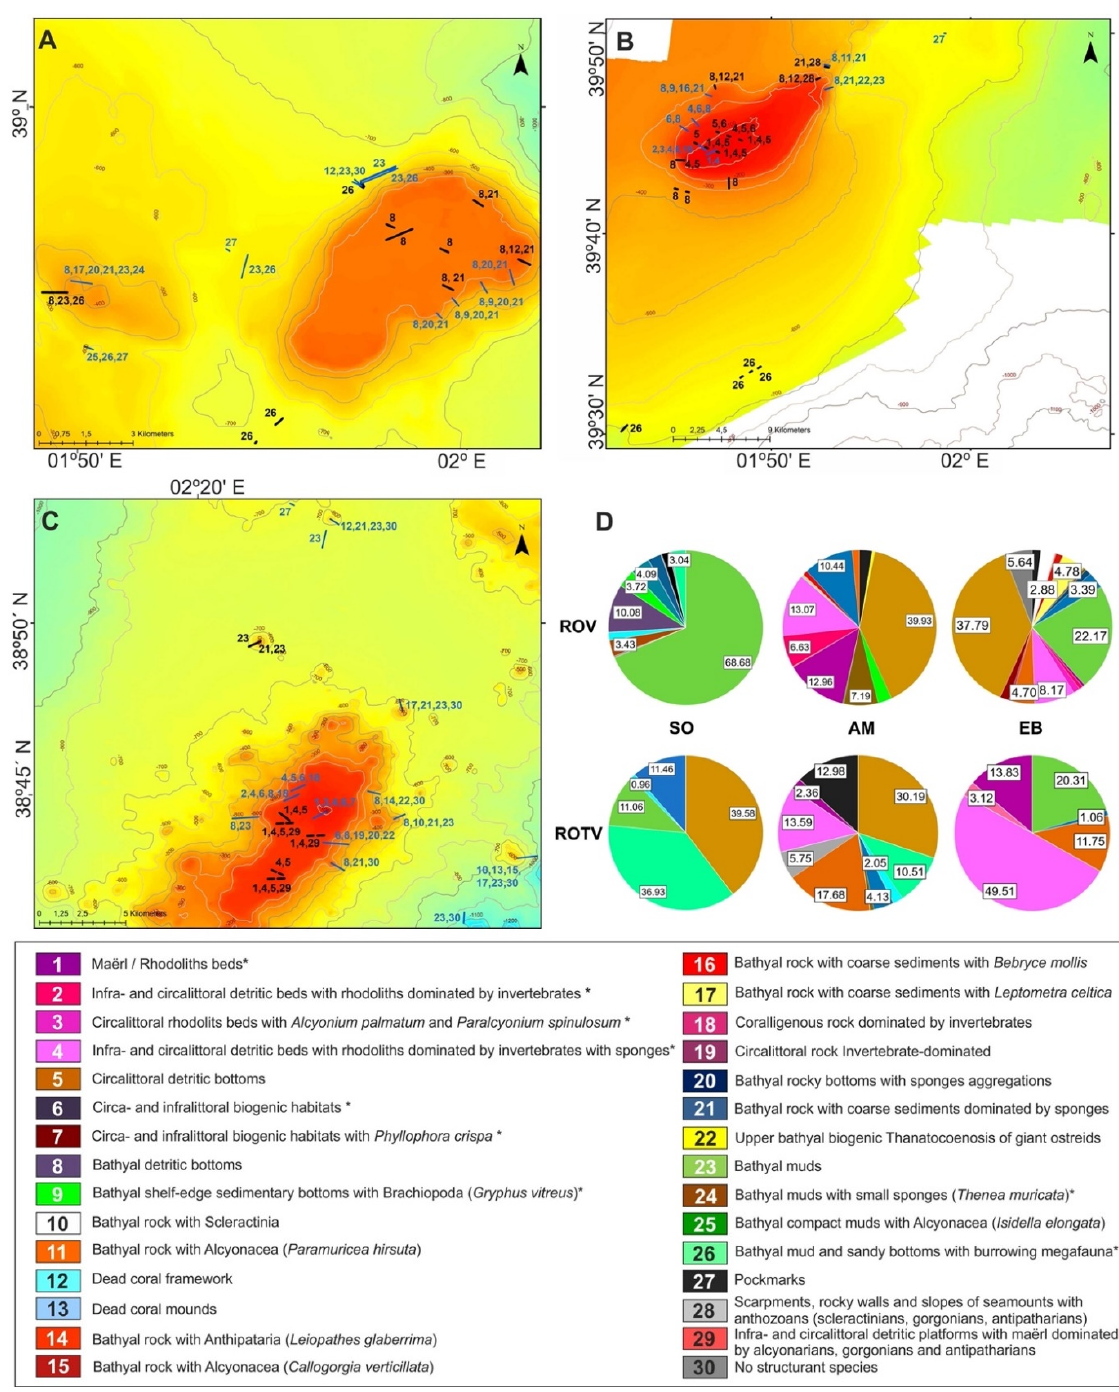
Figure 10. Video transects with ROTV and ROV developed in the ( A ) Ses Olives; ( B ) Ausias March, and ( C ) Emile Baudot seamounts, showing the code (1–29) of the categories of benthic habitats identified. Pie charts with the coverage percentage of the main habitats by seamount are also shown ( D ). (*) Full name, code, and level of habitats are detailed in Table